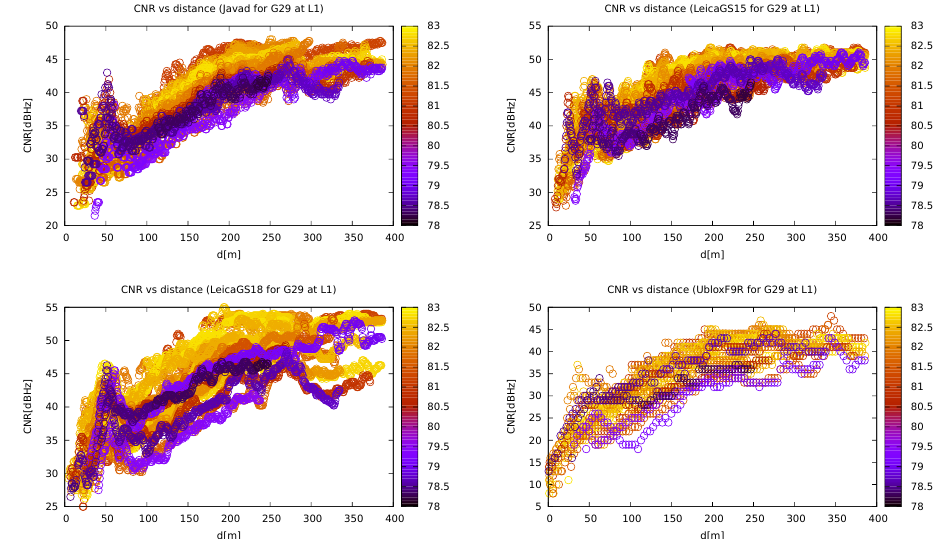
Figure 12. Carrier-to-noise ratio (CNR) of the GPS satellite G29 dependency on distance from jammer for various instruments. Different colours represent different elevations (own study, from the collection